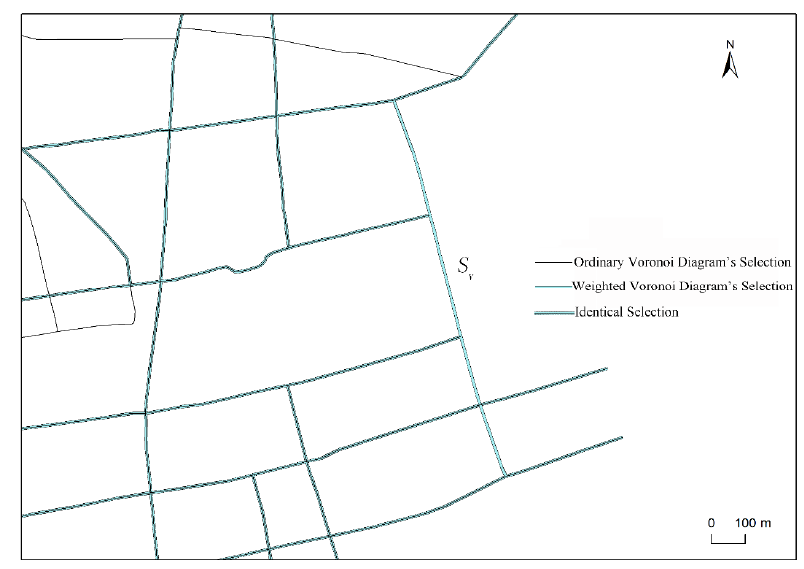
Figure 13. A local comparison of different road selection methods.